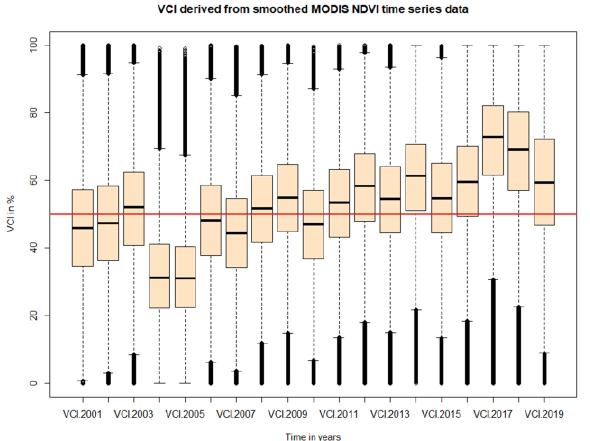
Figure 6. Boxplot of mean annual vegetation condition index (VCI) (%) from 2001 to 2019 in Northeast Thailand. Years under the red line indicate drought anomalies. Figure 7. Drought distribution patterns are based on VCI (%), with the worst drought areas located in north and central areas.